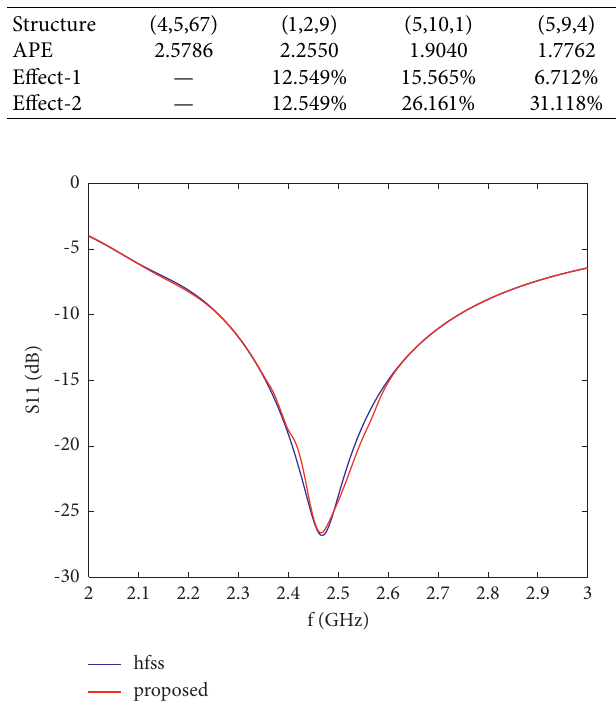
Figure 7: (S) 11 fitting diagram of the PDA.